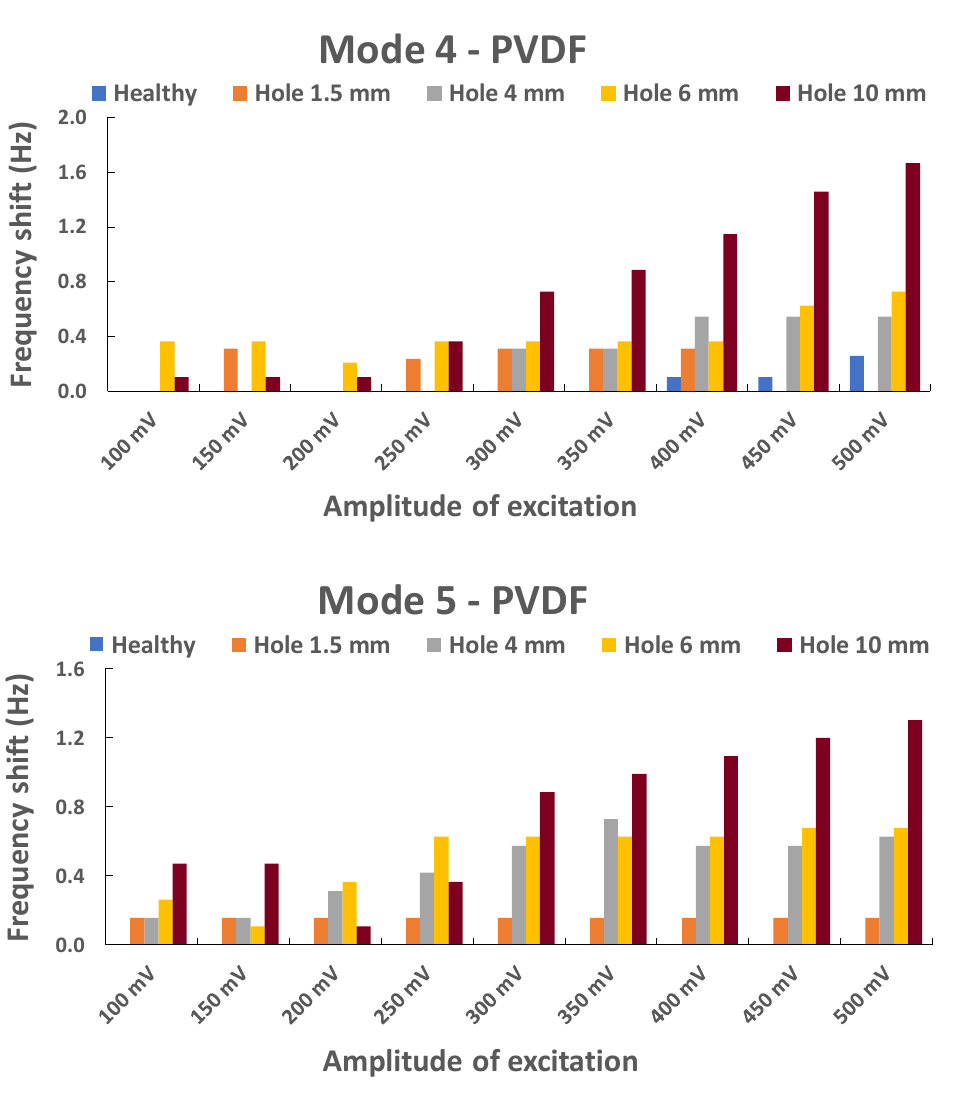
Figure 13. Evolution of the frequency shift in the fourth and fifth natural frequencies with an increasing hole diameter. Table 3. Summary (X: not sensitive; O: sensitive; OO: very sensitive).